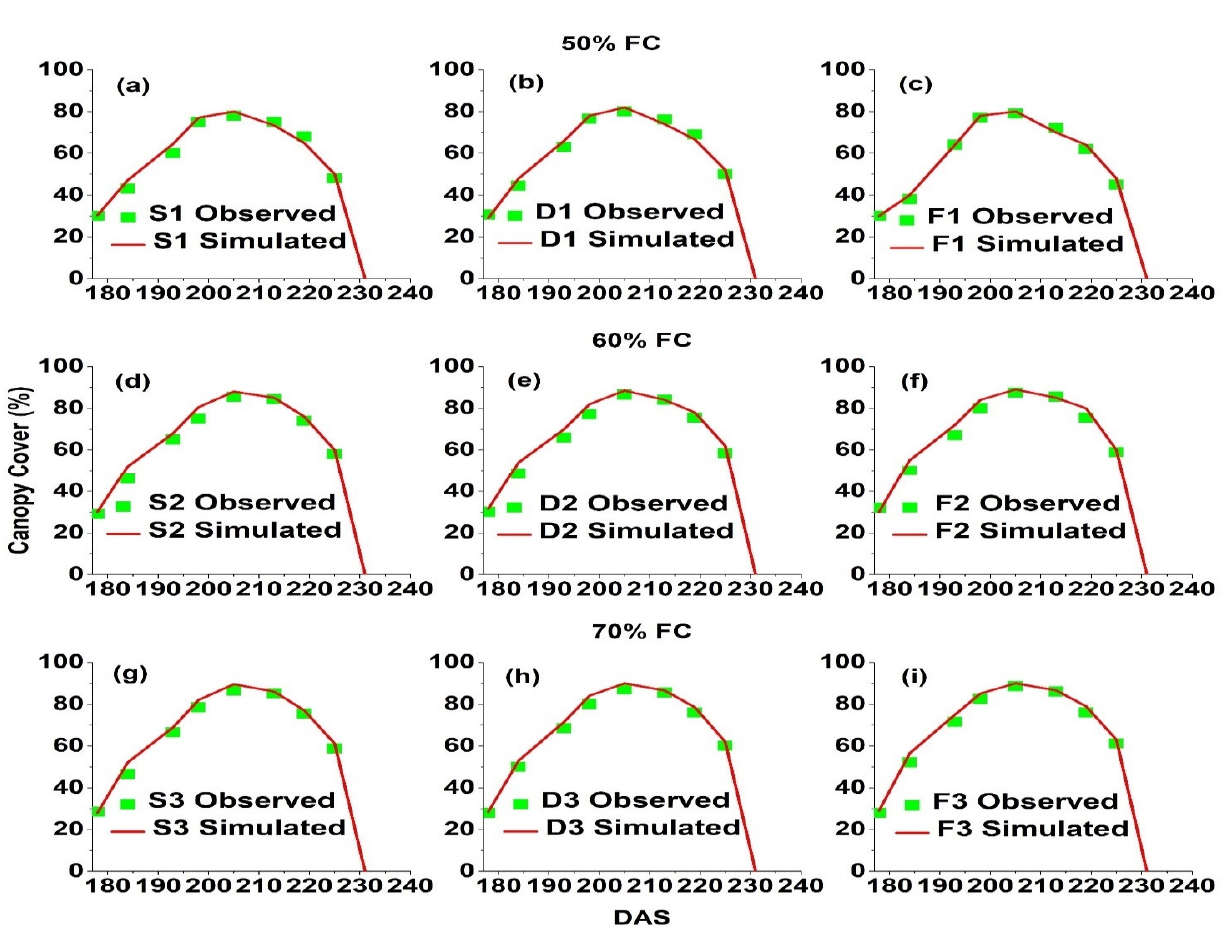
Figure 5. Validation results of canopy cover (%) of winter wheat at 50% FC ( a – c ), 60% FC ( d – f ), and 70% FC ( g – i ) under the sprinkler, drip, and flood irrigation system in 2017–2018. Note: S1: sprinkler irrigation at 50% FC, D1: drip irrigation at 50% FC, F1: flood irrigation at 50% FC, S2: sprinkler irrigation at 60% FC, D2: drip irrigation at 60% FC, F2: flood irrigation at 60% FC, S3: sprinkler irrigation at 70% FC, D3: drip irrigation at 70% FC, F3: flood irrigation at 70% FC. The SWC followed the pattern of 70% FC > 60% FC > 50% FC (Table 10). The minimum deviation in SWC was observed at 60% FC, while the maximum deviation was estimated at the water stress irrigation level (50% FC). The CRM for SWC ranged from − 0.10 to − 0.05, while the RMSE and NRMSE for SWC varied from 10.50–14.70 mm and 3.60–5.52%, respectively. The simulated SWC agreed well with the observed field data . The R 2 and d-index for SWC were 0.98 and 0.86 combined for all treatments (Figure